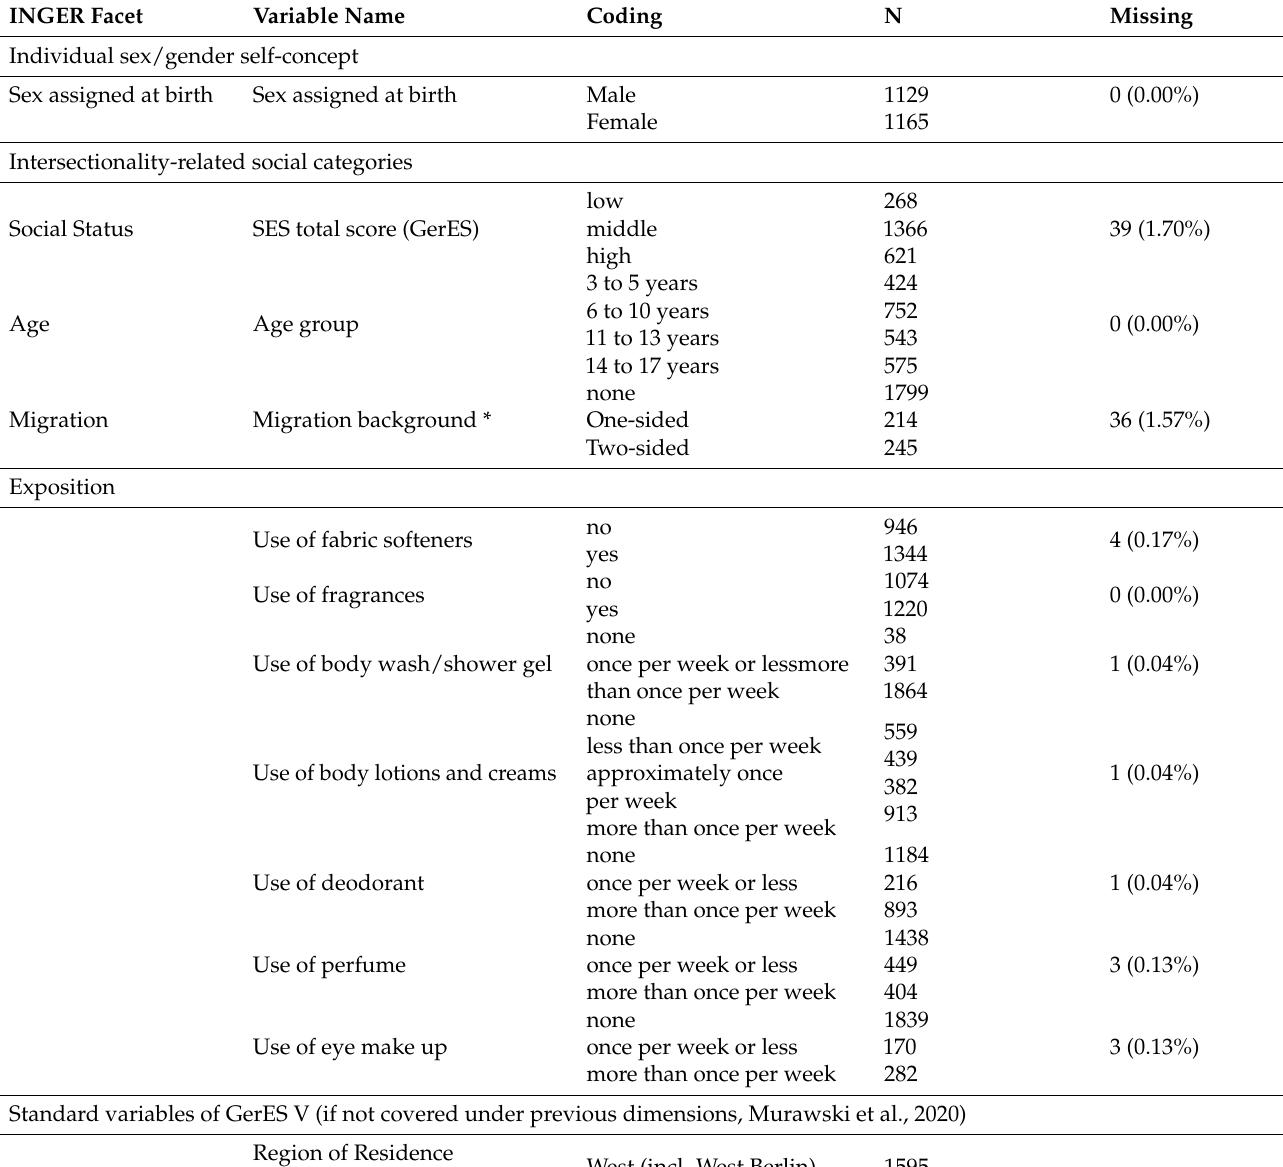
Table 1. Variables selected as most important during decision tree analyses and used in regression analysis. Variables marked with * proved relevant only for